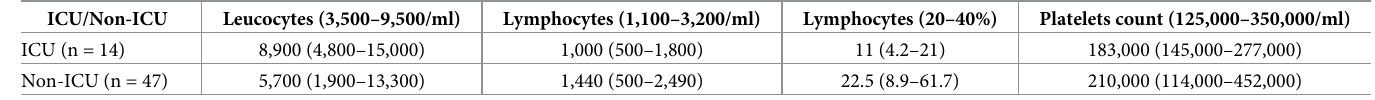
Data collected from 10 to 28 March 2020. Normal ranges of each laboratory parameter are shown in the headers of each column. Values of each cell represent medians. Ranges are depicted in